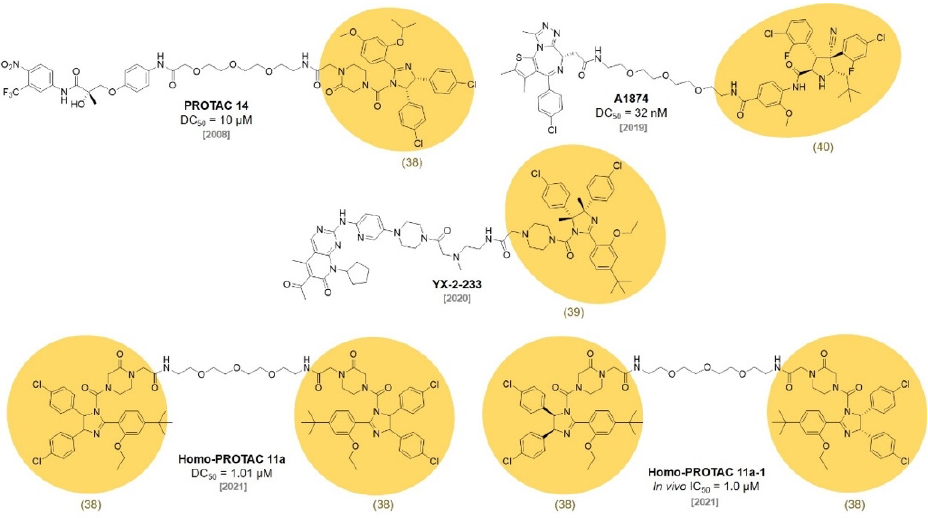
Figure 10. Chemical structures of reported MDM2 ligands.